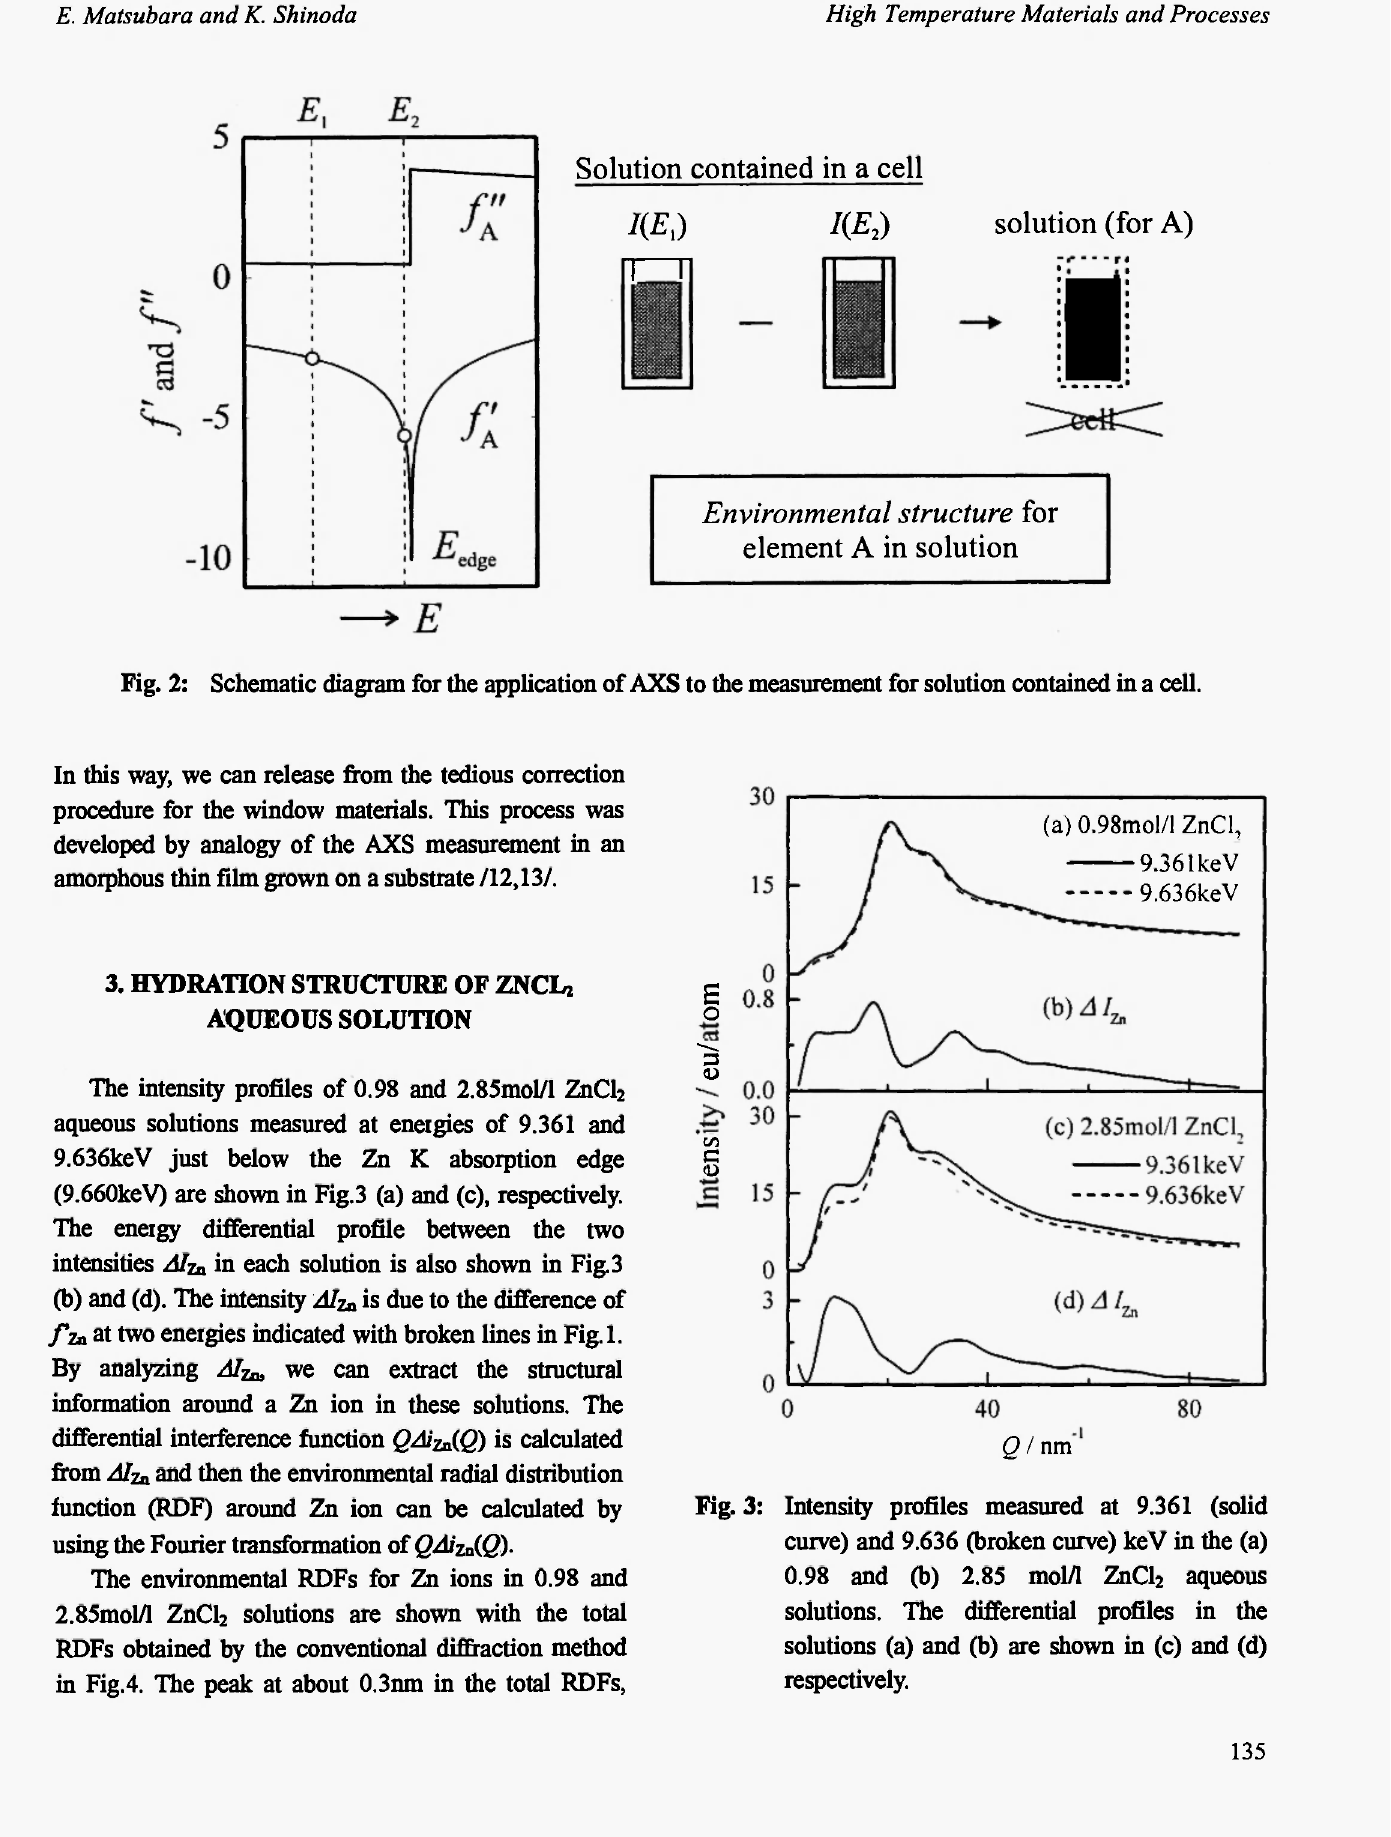
Fig. 2: Schematic diagram for the application of AXS to the measurement for solution contained in a cell.